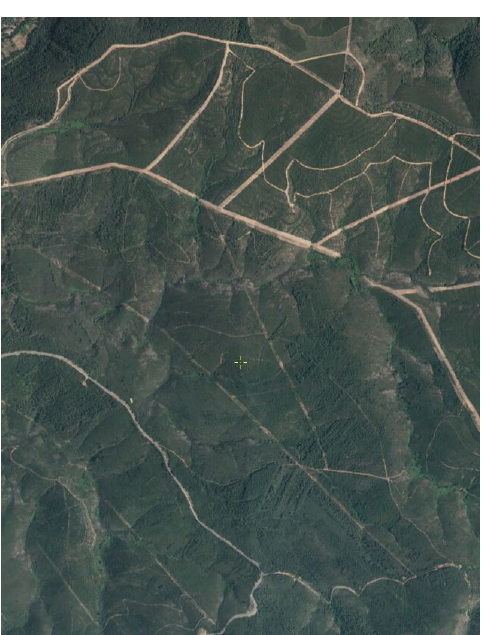
Figure 6: Corrected orthophoto mosaic (part